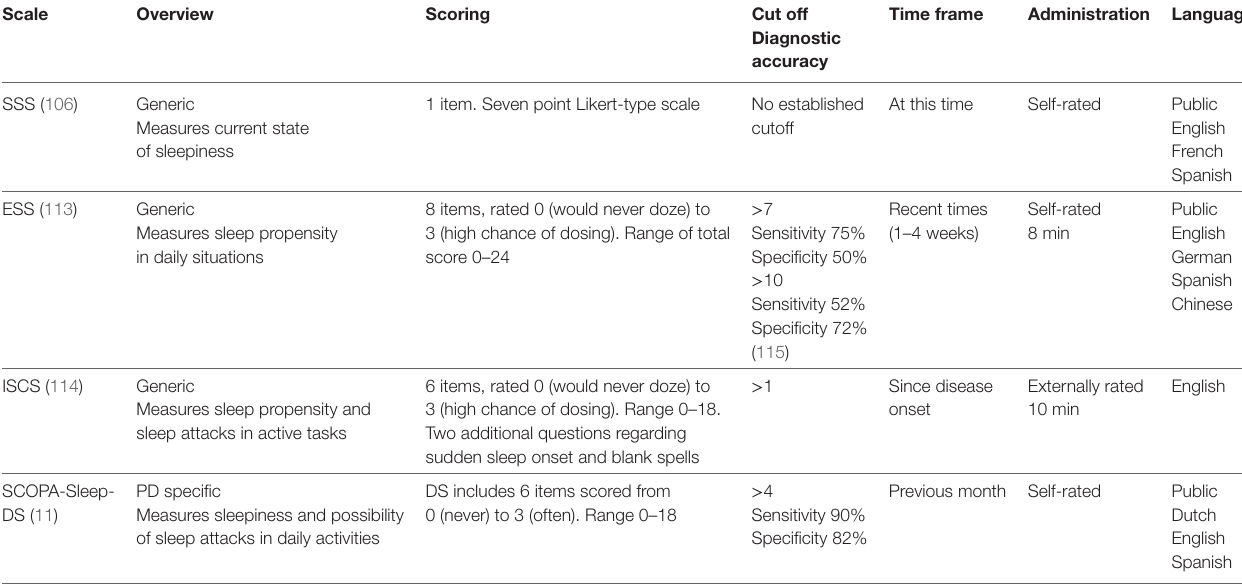
TABLe 4 | Scales that evaluate excessive daytime sleepiness in movement